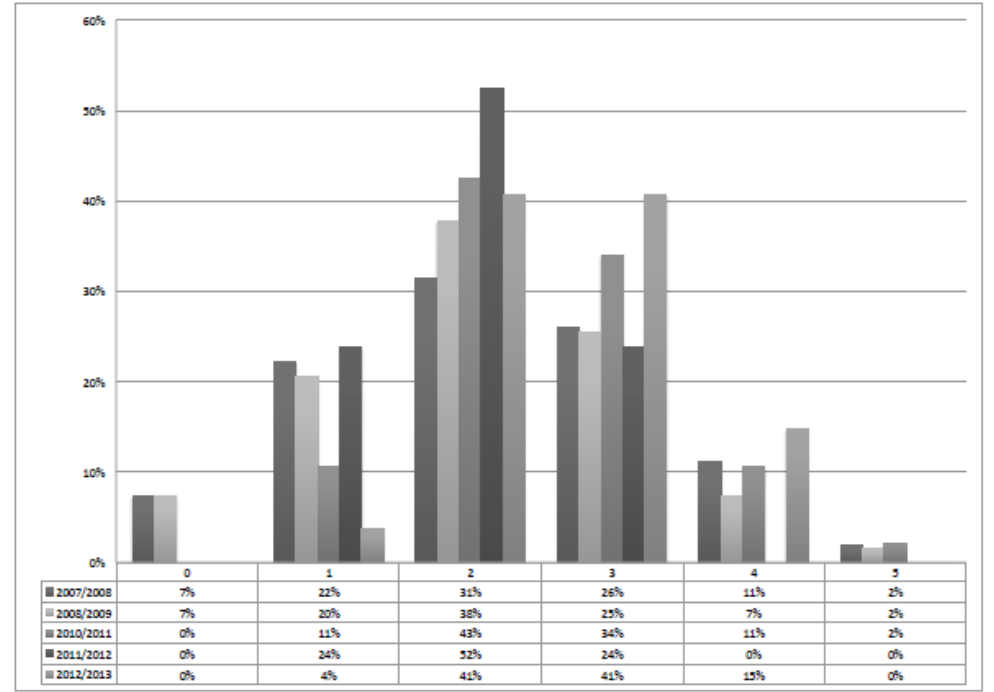
Figure 4. Your knowledge of advanced Java programming language (threads, graphic user interface,